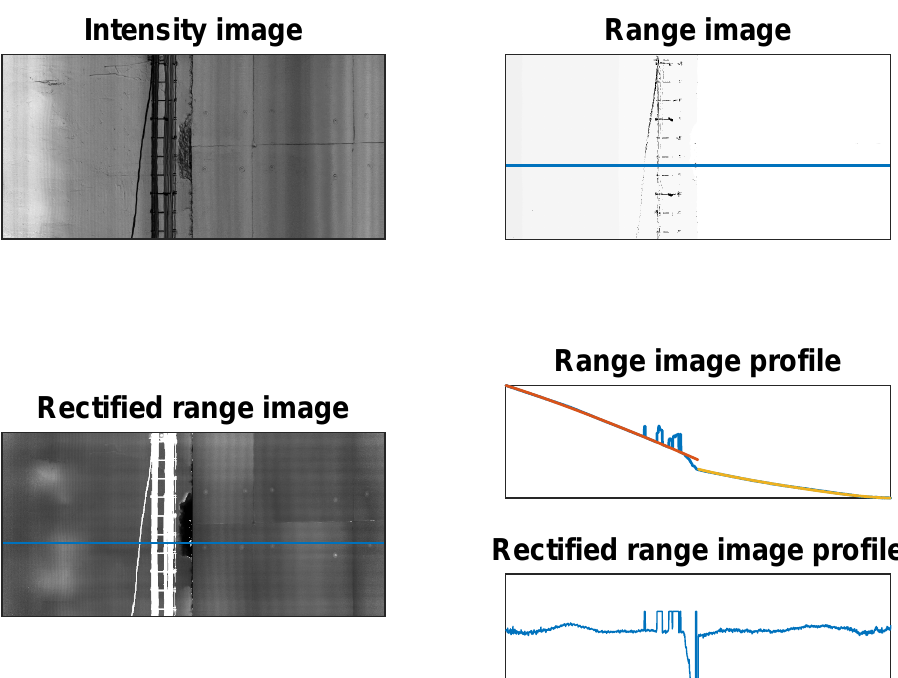
Figure 12. Range image rectification (see text). A piecewise smooth surface is adjusted on the range image (red and yellow curves on the profile). The spall is visible in the rectified range image and profile.